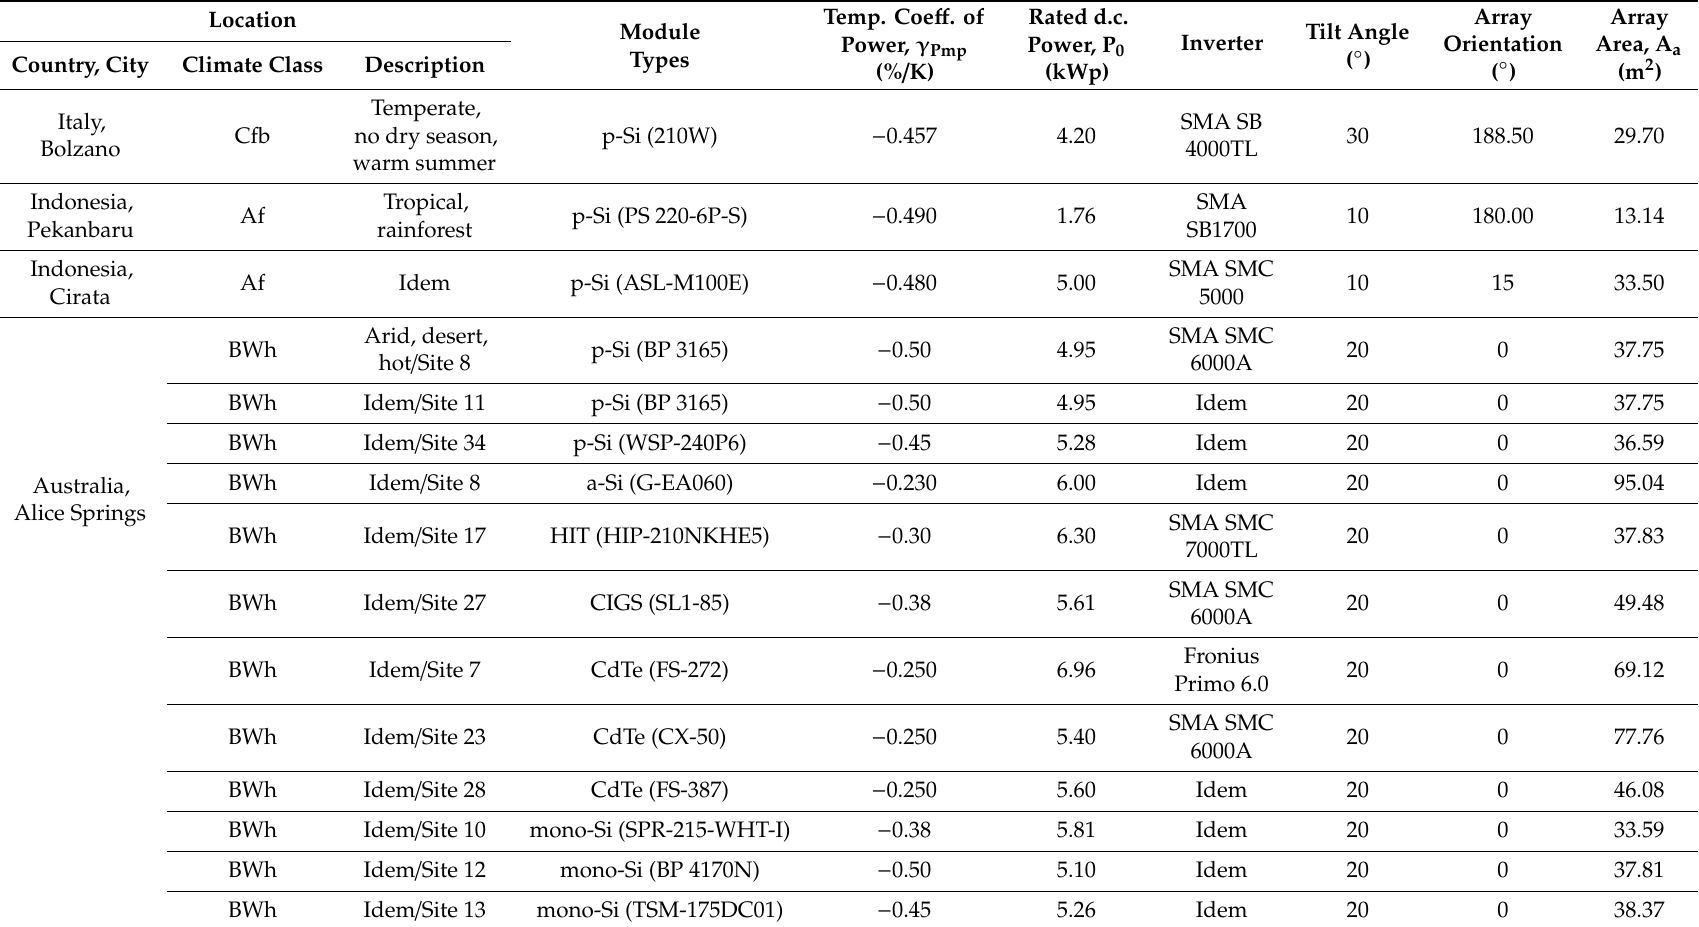
Table 1. General information about the photovoltaic (PV) systems